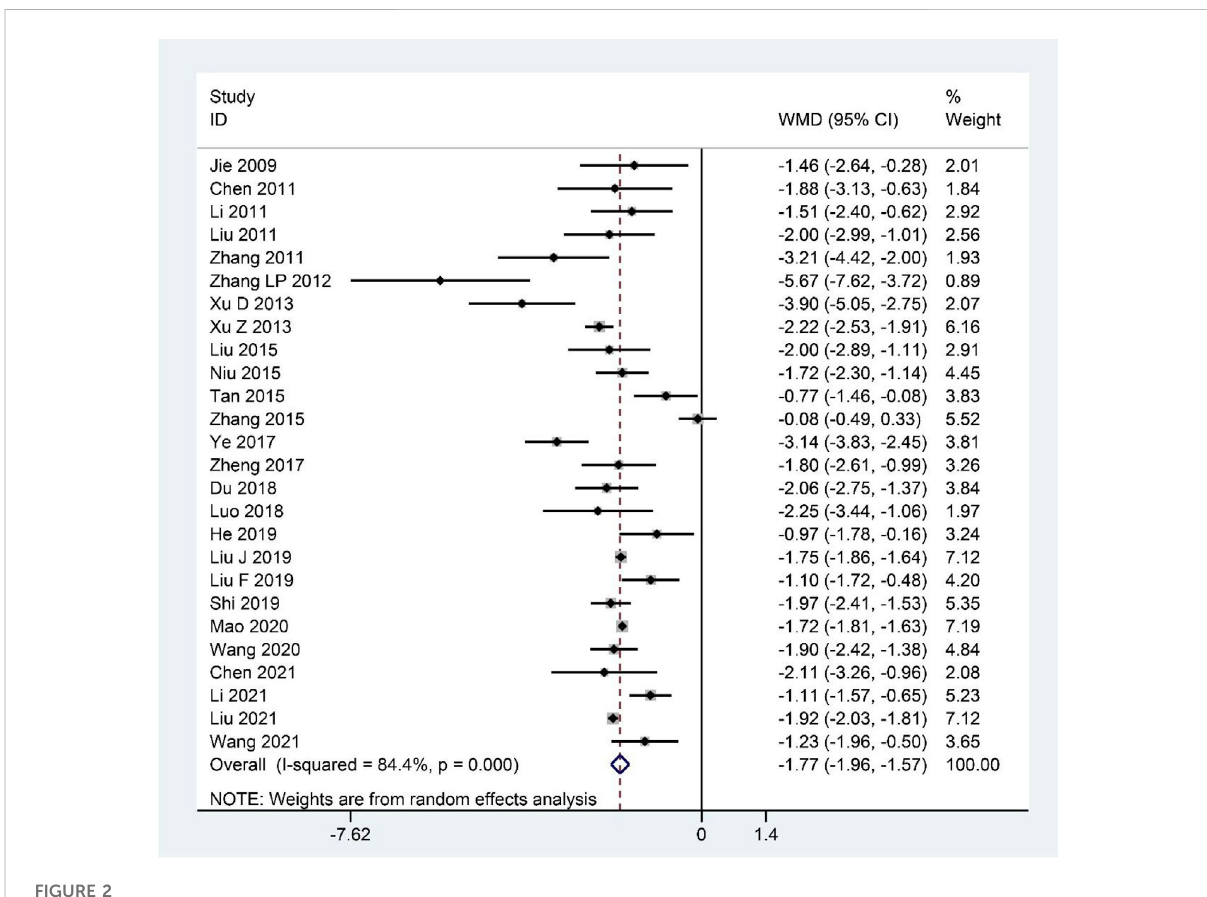
FIGURE 2 Forest plot for FS-14